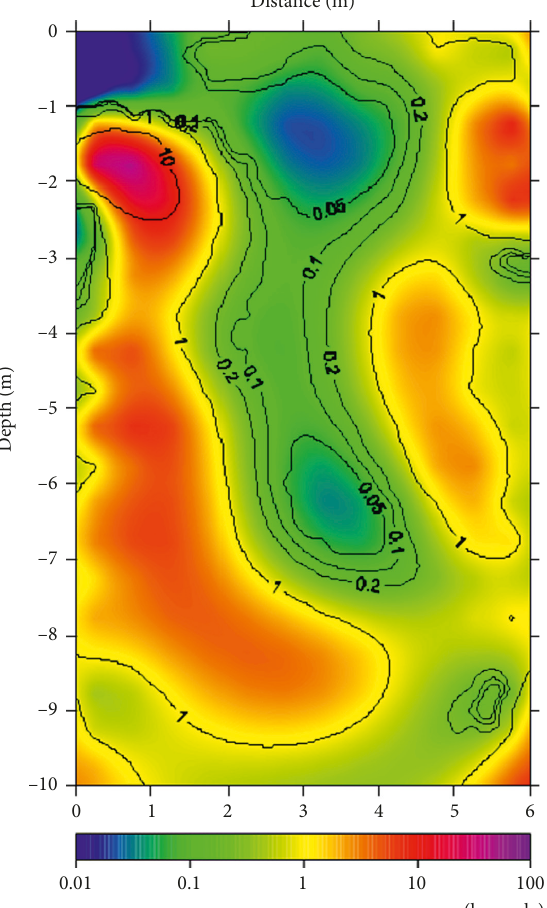
Figure 11: Electrical resistivity ratio contours of 2nd test over 1st